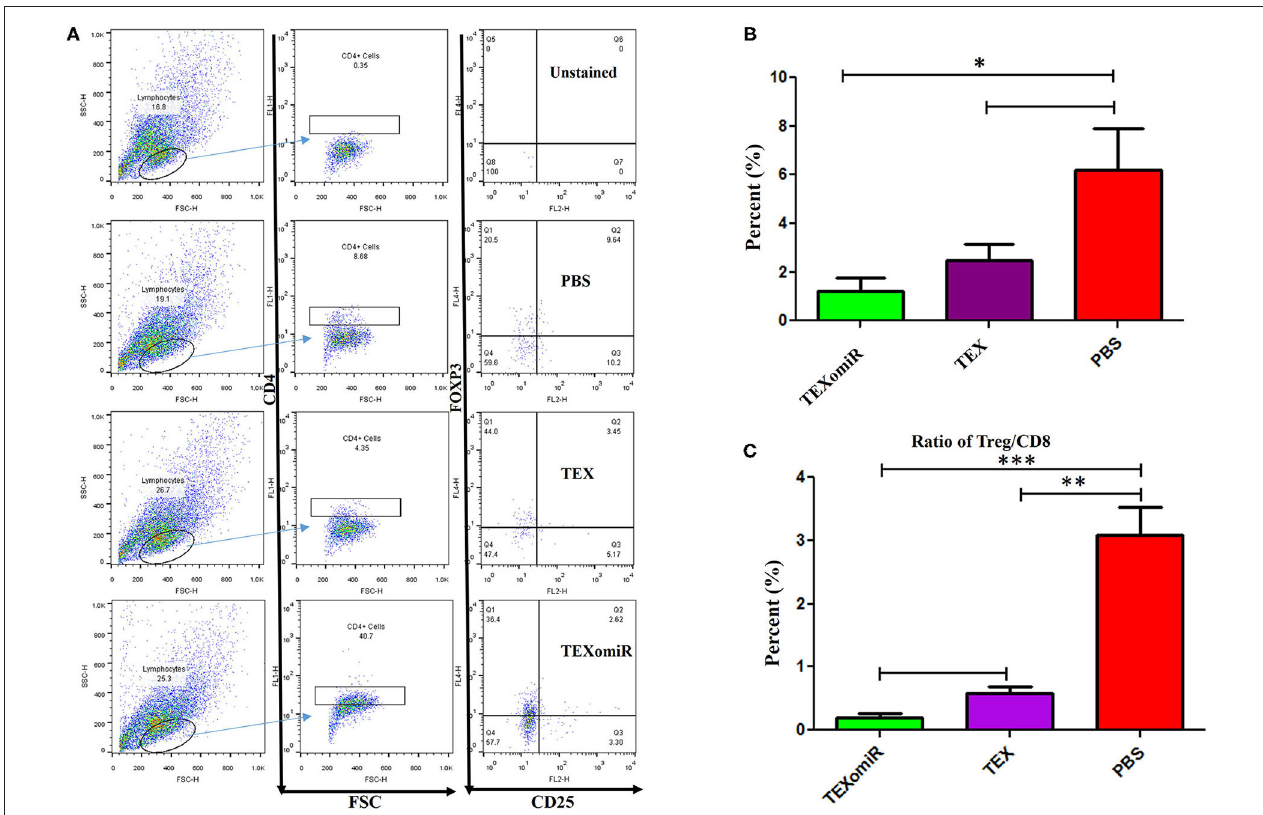
FIGURE 9 | The effect of TEXomiR on tumor-infiltrating CD4 + CD25 + Foxp3 + regulatory T cells. (A) Flow cytometry analysis of tumor-infiltrating CD4 + CD25 + Foxp3 + regulatory T cells in tumor from CT-26 tumor-bearing mice treated with TEXomiR, TEXs, and phosphate-buffered saline (PBS). (B) A significant decrease in the number of tumor-infiltrating CD4 + CD25 + Foxp3 + regulatory T cells was detected in the TEXomiR group compared with the PBS group. (C) The ratio of Treg/CD8 + showed a significant decrease in mice treated with TEXomiR compared with the TEX and PBS-treated mice. The data are presented as mean ± SD. * P < 0.05, ** P < 0.01, *** P < 0.001. One-way ANOVA was used to make comparisons between groups. TEXomiR, miR-124-3p-enriched TEXs; TEX, tumor